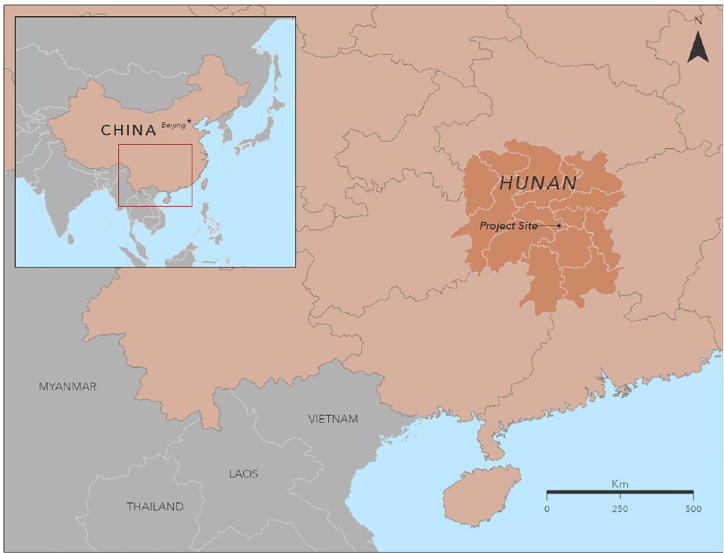
Fig 1. Location of rabies PEP project county A, Hunan Province, China, 2016. Project county is one of 122 counties in Hunan Province. The base layer of the map is from Natural Earth